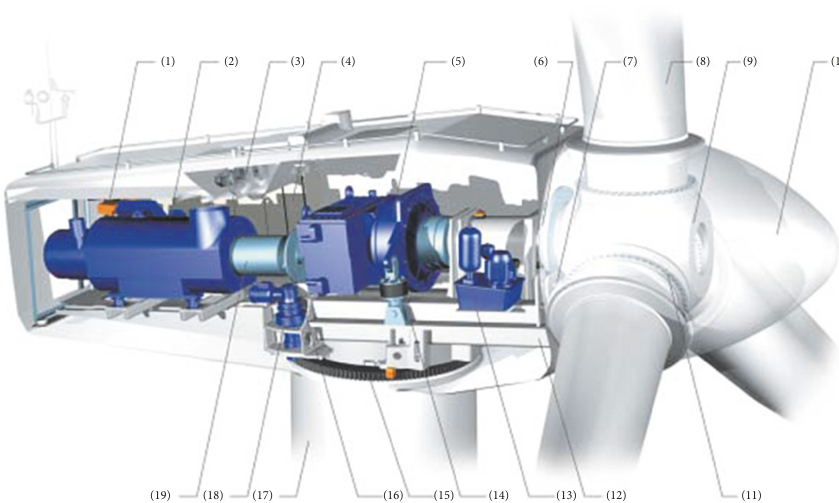
Figure 1: Components of a wind turbine [5]. (1) Service crane. (2) Generator. (3) Cooling system. (4) Top control unit. (5) Gearbox. (6) Main shaft with two bearings. (7) Rotor lock system. (8) Blade. (9) Hub. (10) Hub cover. (11) Blade bearing. (12) Bed frame. (13) Hydraulic unit. (14) Shock absorbers. (15) Yaw ring. (16) Brake. (17) Tower. (18) Yaw gears. (19) Transmission high speed